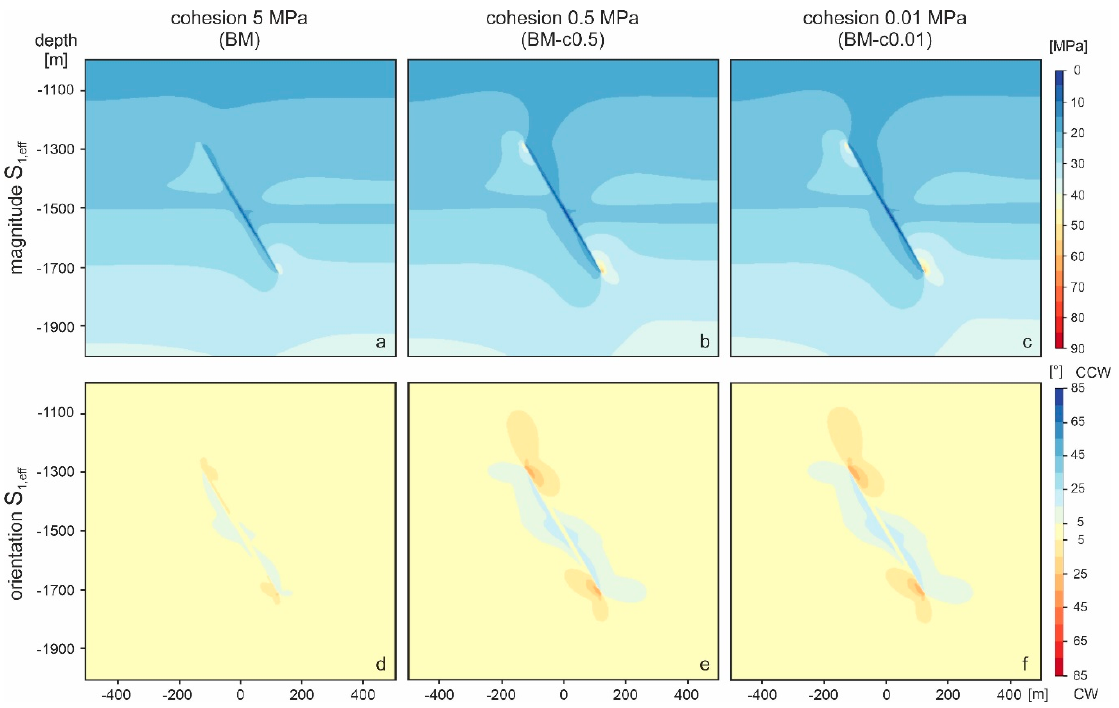
Figure 8. Spatial variations in the magnitude ( a – c ) and orientation (deviation from vertical; d – f ) of the effective maximum principal stress (S 1,eff ) after five years of injection for three different cohesion values assigned to the fault zone.